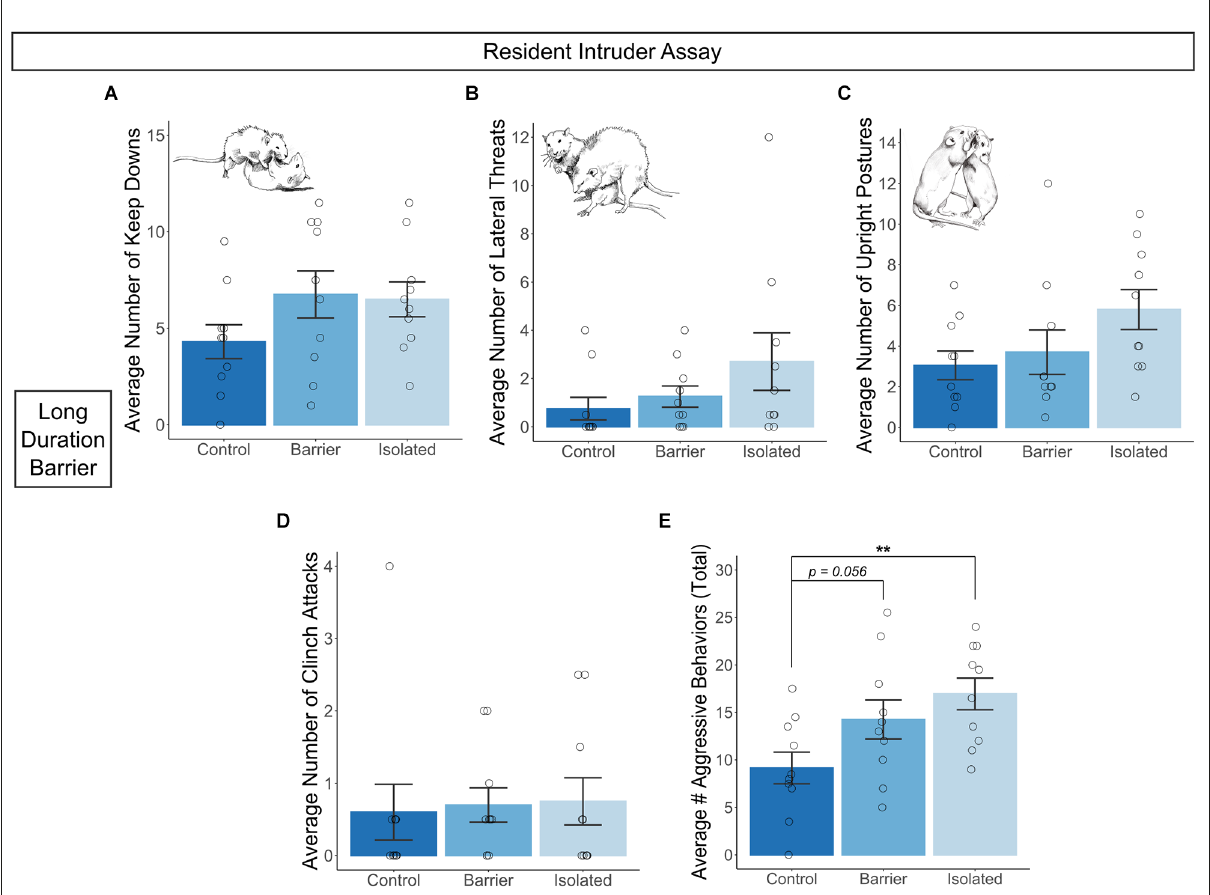
FIGURE9 Juvenile play deprivation increases adult aggressive behavior in males. Quantification of the average number of keep downs (A) , lateral threats (B) , upright postures (C) , and clinch attacks (D) exhibited by each resident male subject towards a novel intruding stimulus male in two 15-min tests in the long duration barrier experiment. Cartoon insets in (A–C) depict the assessed behavior in question. The average number of total aggressive behaviors is shown in (E) . Bars indicate group means ± SEM, and open circles represent data from individual rats. ** p < 0.01, n = 10 per